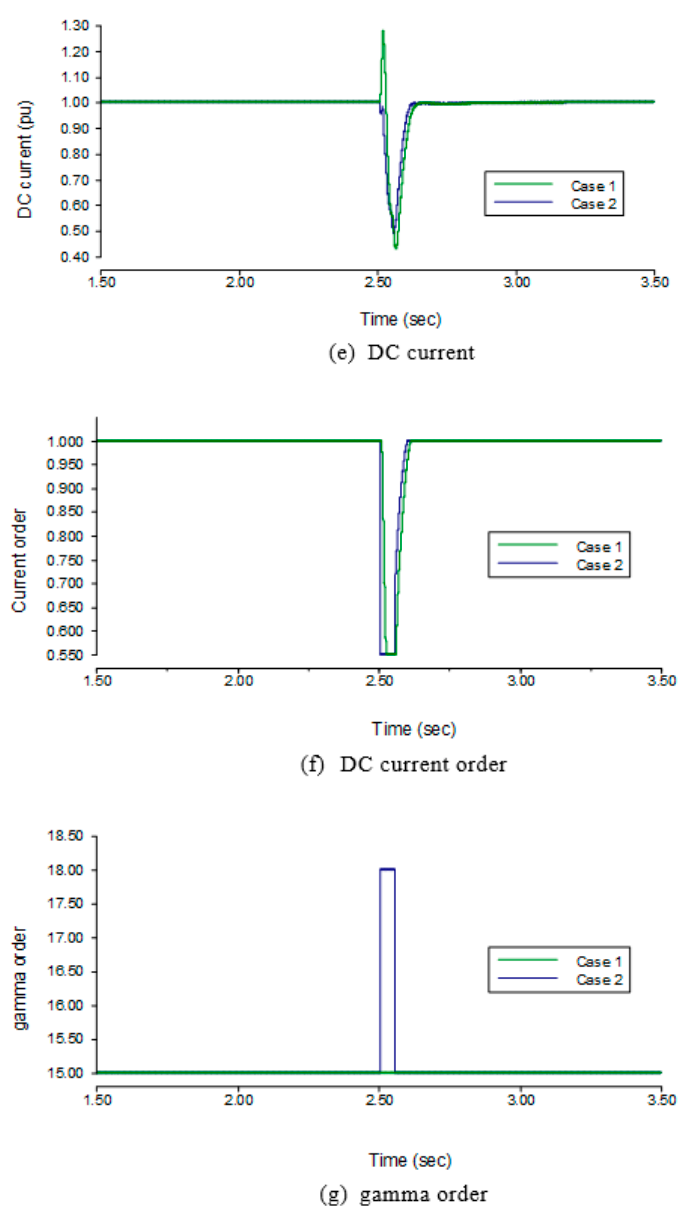
Figure 9. Transient state performance of the three-phase fault to the ground with severe AC fault.